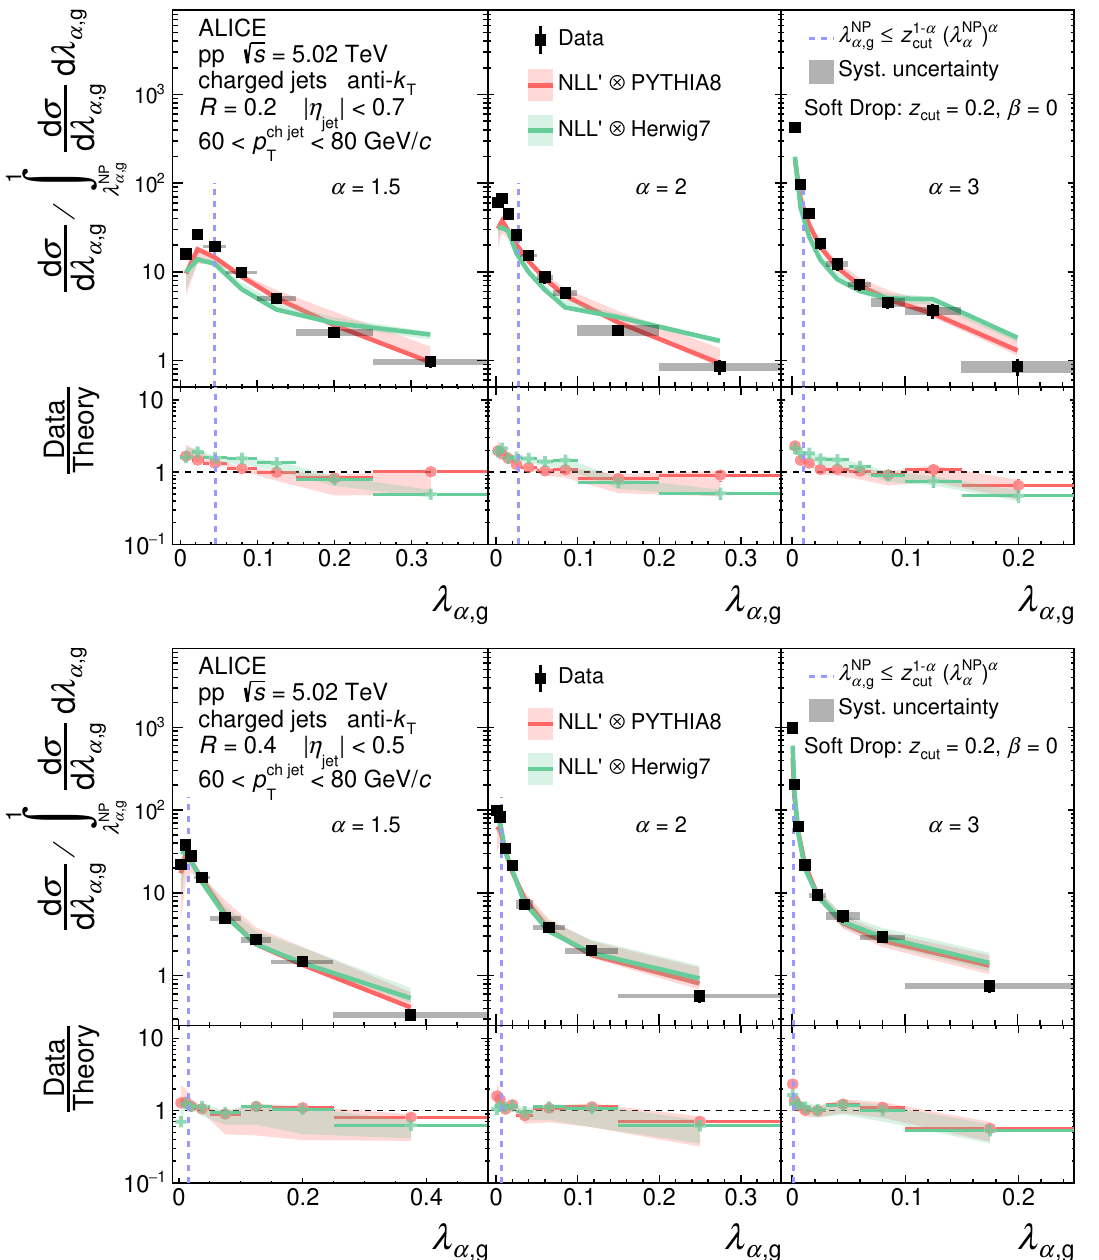
Figure 6 . Comparison of groomed jet angularities λ α, g in pp collisions for R = 0 . 2 (top) and R = 0 . 4 (bottom) to analytical NLL 0 predictions with MC hadronization corrections in the range 60 < p ch jet < 80 GeV /c . The distributions are normalized such that the integral of the perturbative T region defined by λ α, g > λ NP (to the right of the dashed vertical line) is unity. Divided bins are α, g placed into the left (NP)